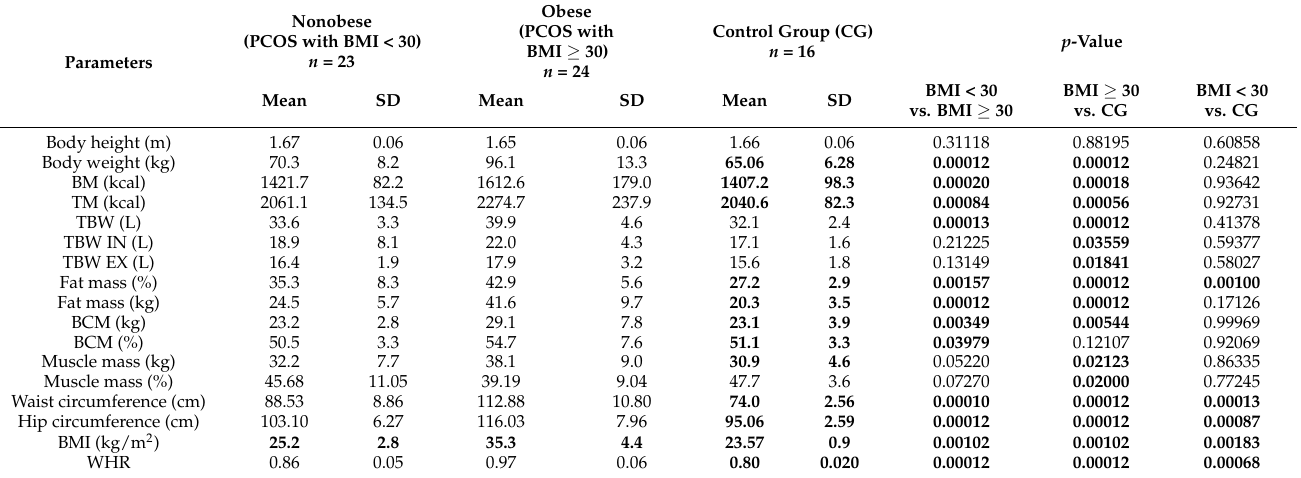
Table 1. Characteristics of patients with